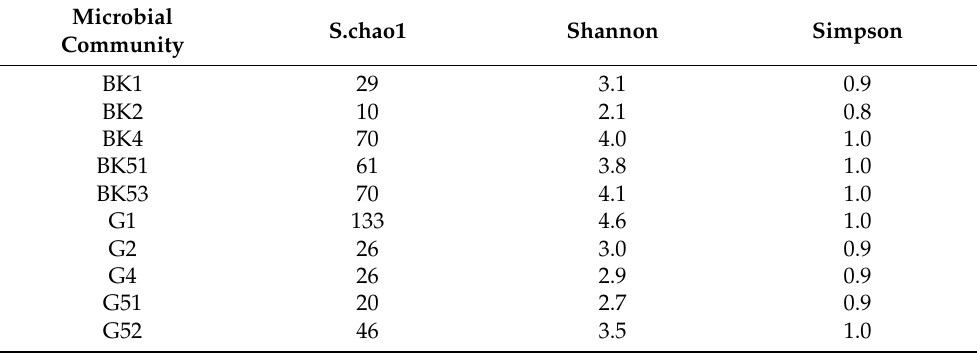
Table 6. Alpha-diversity of rhodopsin-containing microbial communities of epilithon (G51, G52, BK51, BK53), neuston (BK1, G1), and plankton (BK2, BK4, G2, G4) of Lake Baikal. BK—samples taken off the Bol’shiye Koty settlement; G—samples taken off the Bol’shoye Goloustnoye settlement. Microbial Community